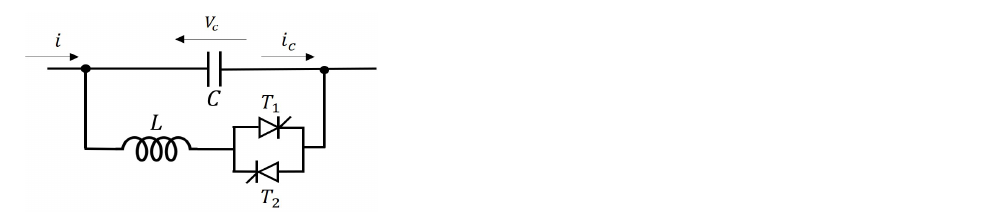
Figure 7. Thyristor-Controlled Series Capacitor (TCSC) basic scheme. Adapted from Reference [4].